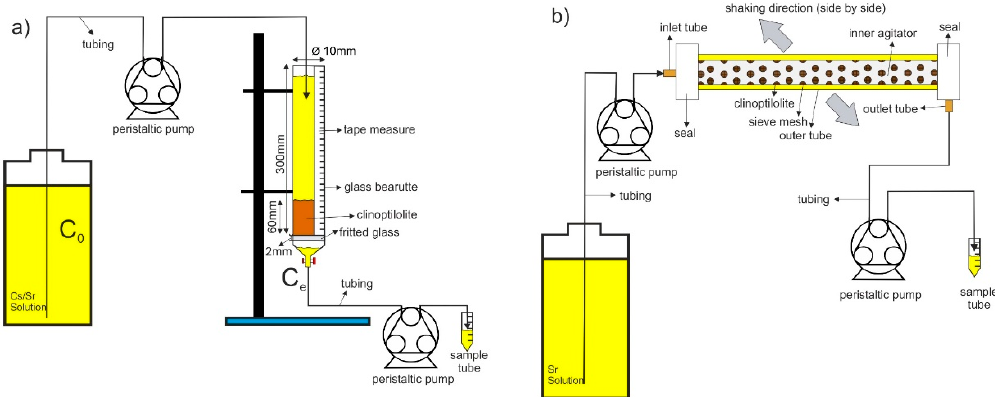
Figure 1. Schematic diagrams showing ( a ) static vertical ion exchange column and ( b ) agitated tubular reactor (ATR) with a horizontal ion exchange column.